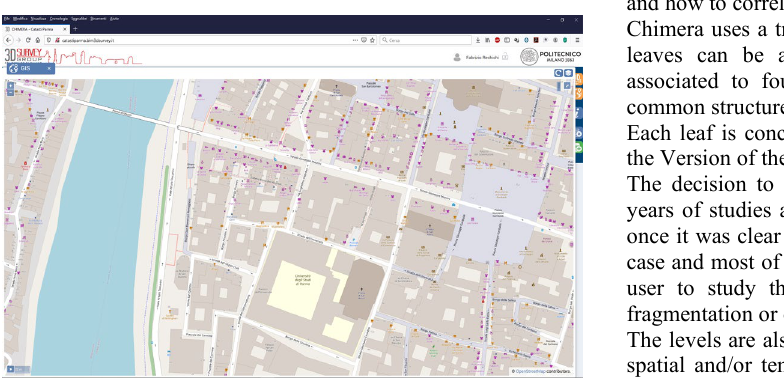
Figure 4 – GIS component working with OpenStreetMap.